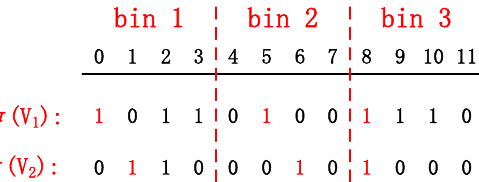
Figure 3. An example of one-permutation min-wise